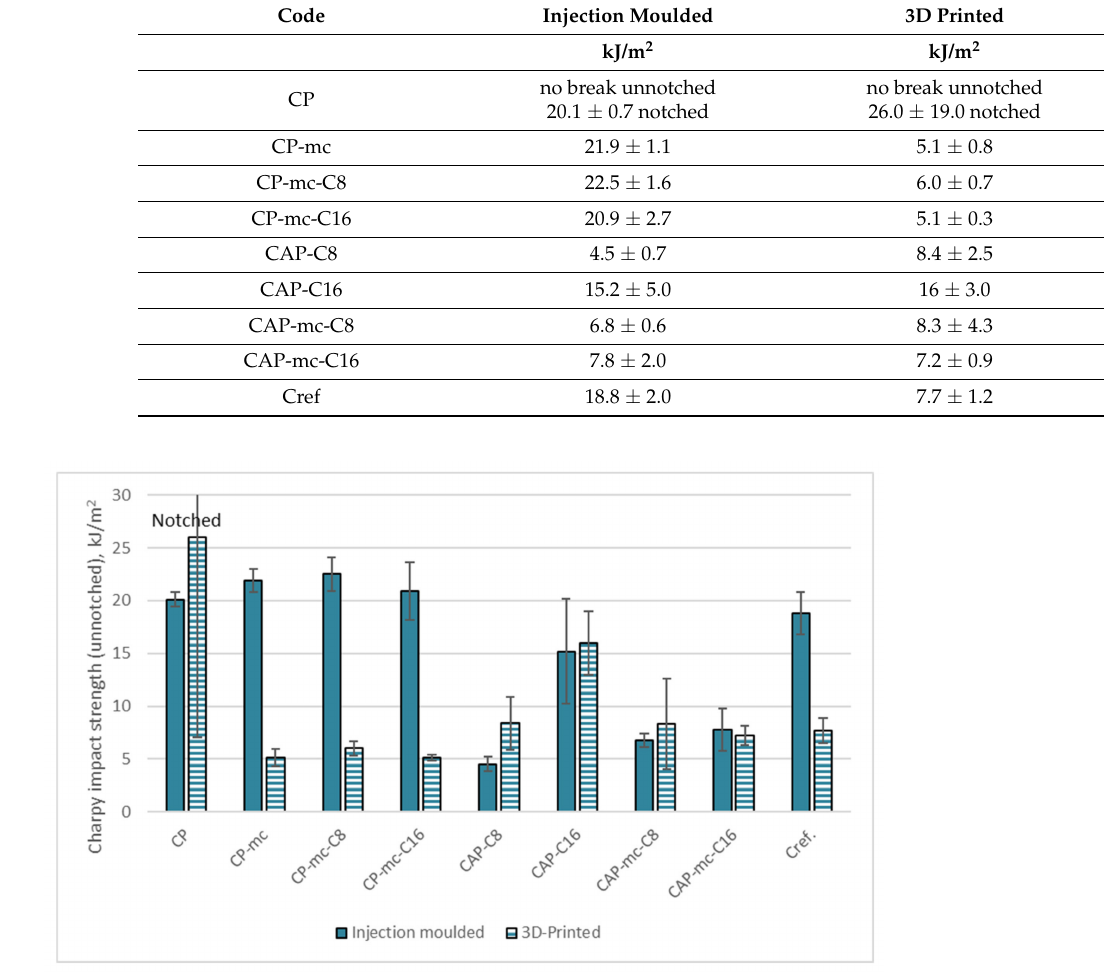
Figure 10. Charpy impact strength results for injection molded and 3D printed materials. Unnotched samples except CP, which did not break as unnotched. CP is commercial cellulose acetate propionate with 13% commercial plasticizer; CP-mc is 20% microcellulose containing CP; CP-mc-C8 contains also 4% cellulose octanoate C8; CP-mc-C16 contains 4% of cellulose palmitate C16; CAP-C8 contains neat cellulose acetate propionate (CAP) with 17% C8; CAP-C16 contain 17% C16 in CAP; CAP-mc-C8 contains 20% mc and 17% C8 in CAP; CAP-mc-C16 contains 20% mc and 17% C16 in CAP and Cref is PLA-based material with 20% cellulose